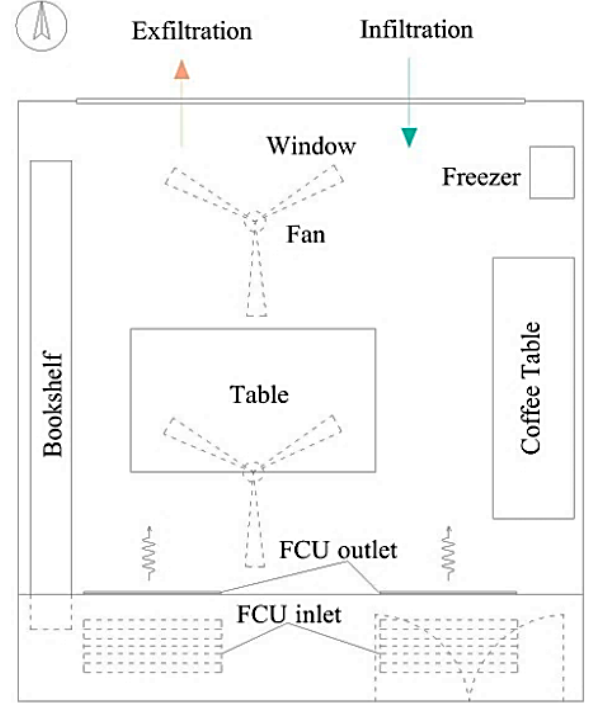
Figure 2. Schematic of the tested office room.